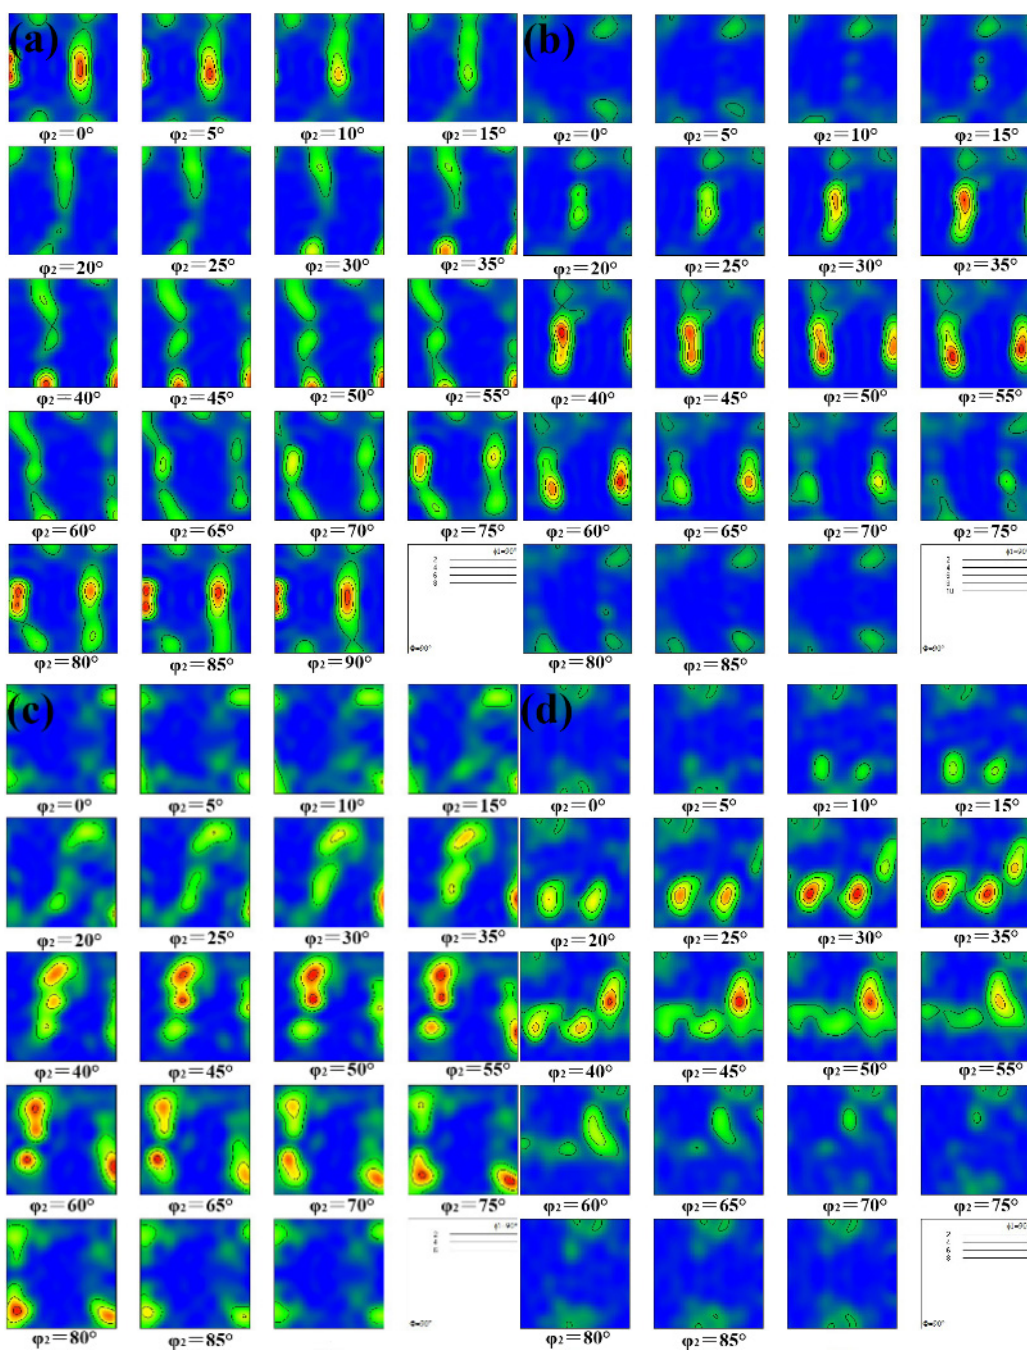
Figure 2. The ODF sections of the Cu–1Cr–0.2Si alloy after different passes deformation and aging at 350 °C for 4 h: ( a ) 1 pass; ( b ) 2 passes; ( c ) 4 passes; ( d ) 8 passes. 350 ◦ C for 4 h: ( a ) 1 pass; ( b ) 2 passes; ( c ) 4 passes; ( d ) 8